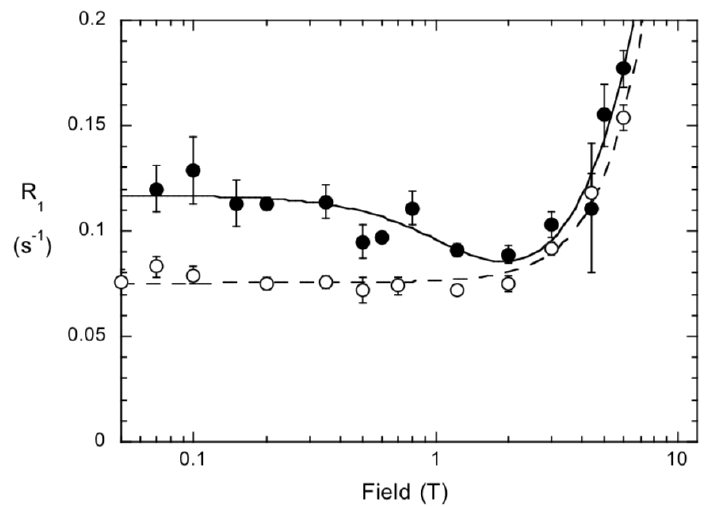
Figure 12. Dependence of 31 P R 1 on B relax for diC 4 PC (5 mM) mixed with 0.0144 mM spin-labeled H82C (o) or D205C ( • ). The profile for diC 4 PC with labeled H82C is essentially the same as diC 4 PC without the protein.